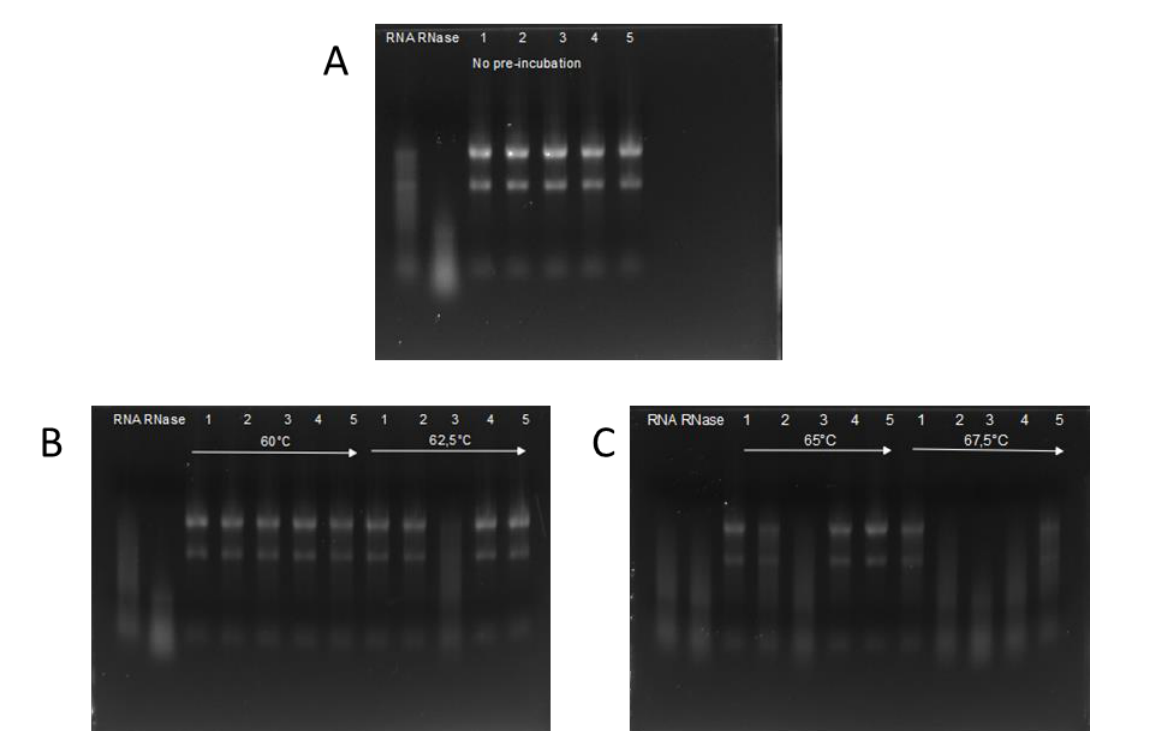
Figure 2. Remaining activity of RI after 30 min incubation at elevated temperatures. In each block, pre-heat temperatures are indicated. RNA is run on an e-gel after incubation with RNase A and the pre-heated RI. In all measurements, lane 1 denotes ‘insect RI’; lane 2 ‘RI I’, lane 3 ‘RI II’; lane 4 ‘RI III’; and lane 5 ‘RI IV’. RNA denotes the experiments without adding either RNase nor RI, and lane RNase is with added RNase, but no RI. Panel A: Remaining activity of RIs with no pre-incubation. Panel B: Remaining activity of RIs with pre-incubation at 60°C and 62.5°C on the left and right side respectively Panel C: Remaining activity of RIs with pre-incubation at 65°C and 67.5°C on the left and right side respectively.